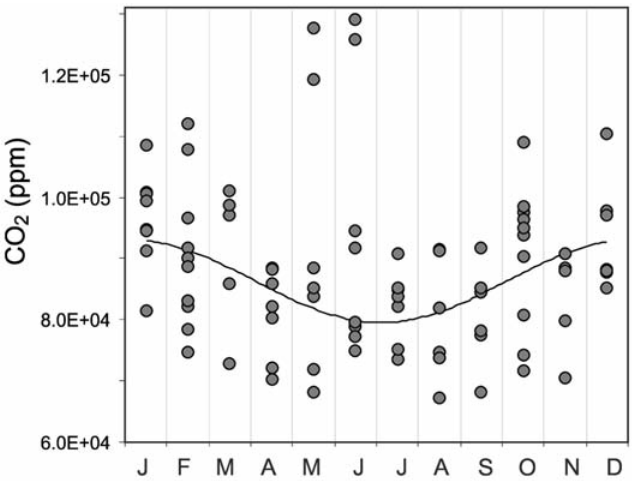
Figure 7. CO de-trended contents of the FC2 fluids (see text) versus the 2 months of sampling. A cyclical annual behavior is seen, with the higher values characterizing the cold months (enhanced condensation), which supports the occurrence of condensation